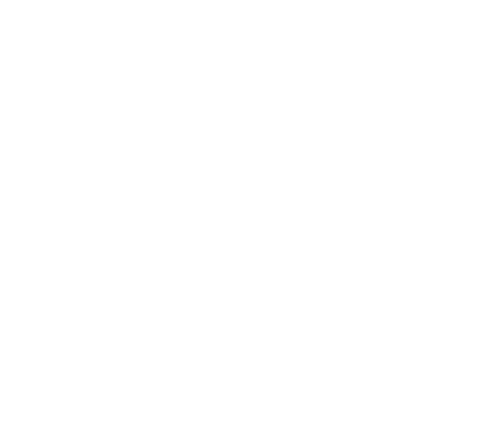
Figure 18. FTIR spectra of samples treated with a different number of flame treatments (0, 1, 3, 5 and